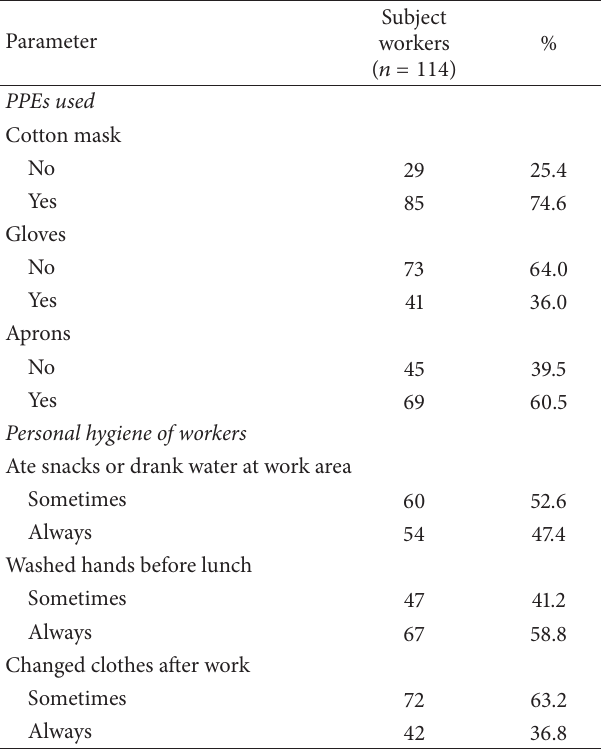
Table 3: PPEs used and personal hygiene behaviors characteristic of the subject workers.